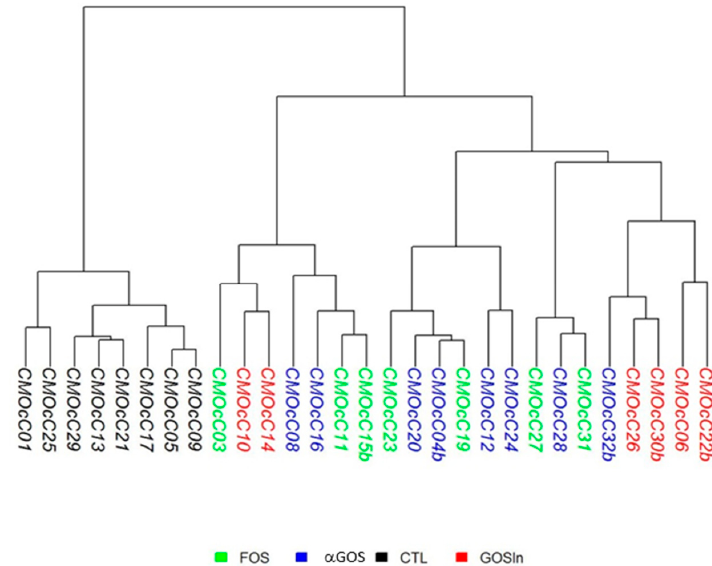
Figure 1. Hierarchical clustering based on the Ward’s method of phylogenetically informed distance matrix computed using the weighted UniFrac metric for cecocolonic contents collected at postnatal day (PND) 14/15 ( n = 6 to 8 per group).